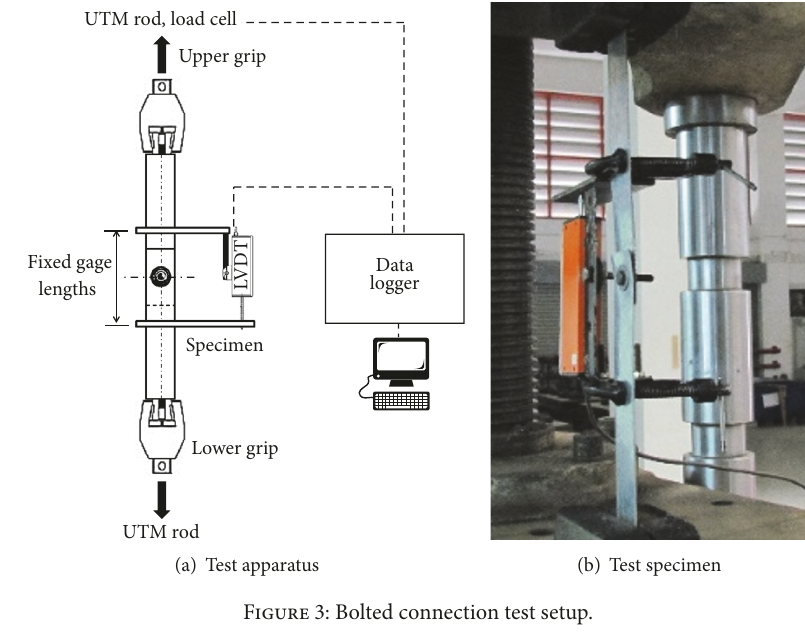
Figure 3: Bolted connection test setup.